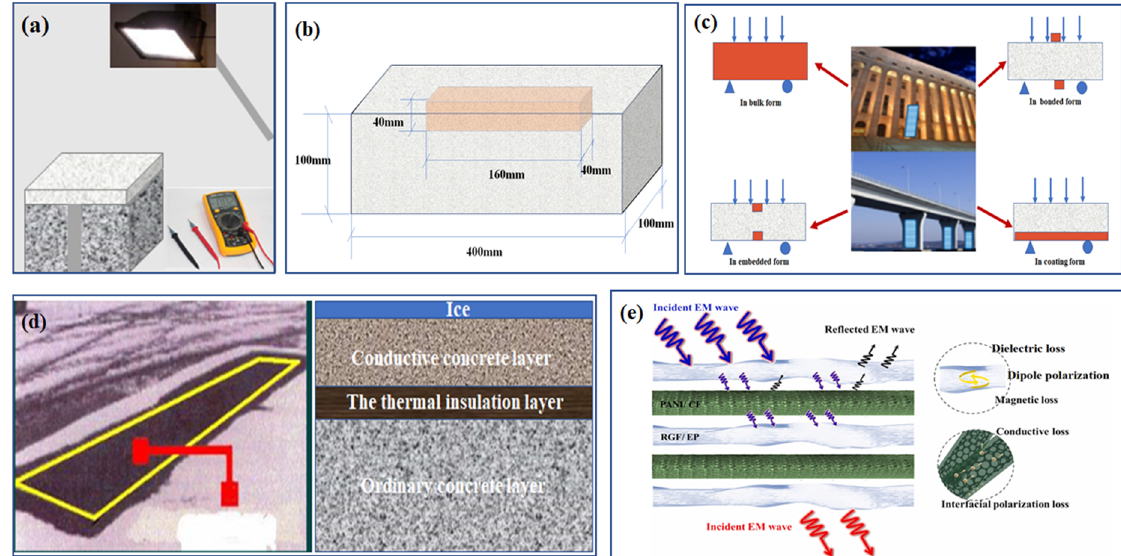
Figure 12. The application of CFRC in ( a ) Thermoelectric energy harvesting, ( b ) Intelligent adjust- ment, ( c ) Structural health monitoring, ( d ) Melting snow and ice, and ( e ) Electromagnetic shielding. (( a , b , d ) are proposed by this paper while ( c , e ) are from Ref. [27] and Ref. [119], respectively).